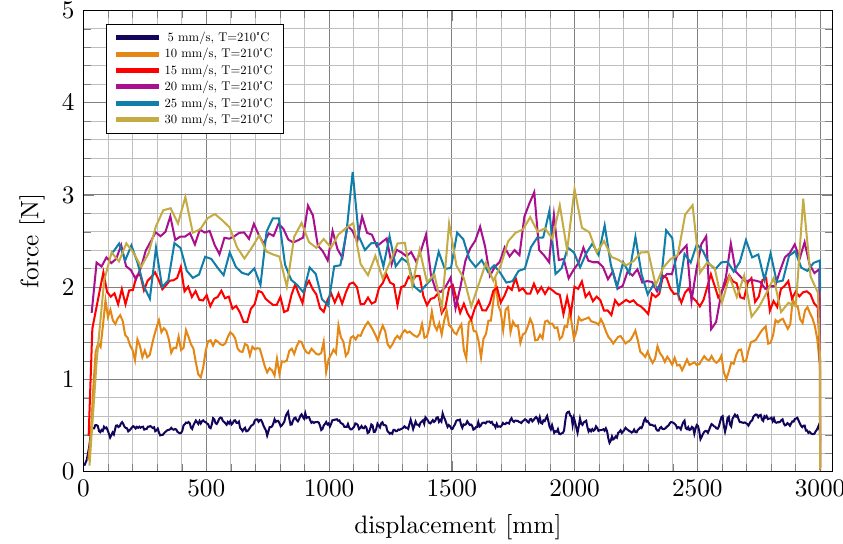
Figure 9. Deforming forces of GF-PP at 210°C and D fe = 1.2mm.